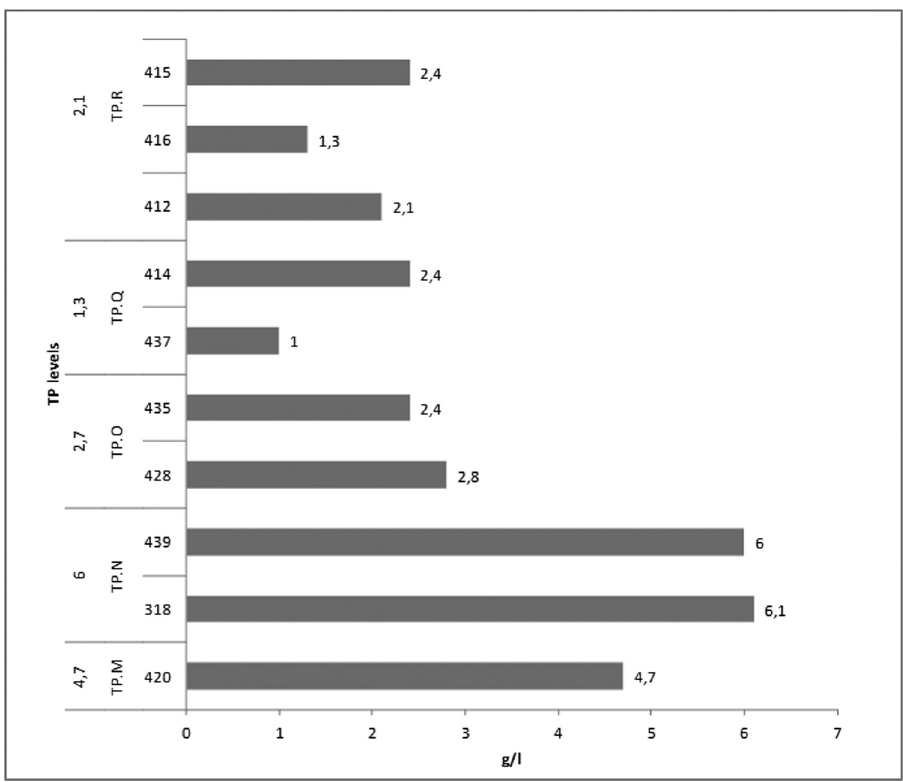
Figure 4: Çatalhöyük East, TP middens. Bar chart showing midden density through TP levels and the spaces within them.